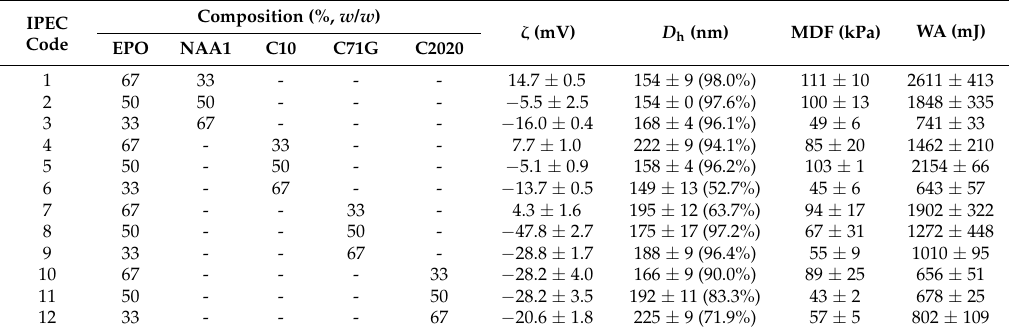
- - 67 − 20.6 ± 1.8 225 ± 9